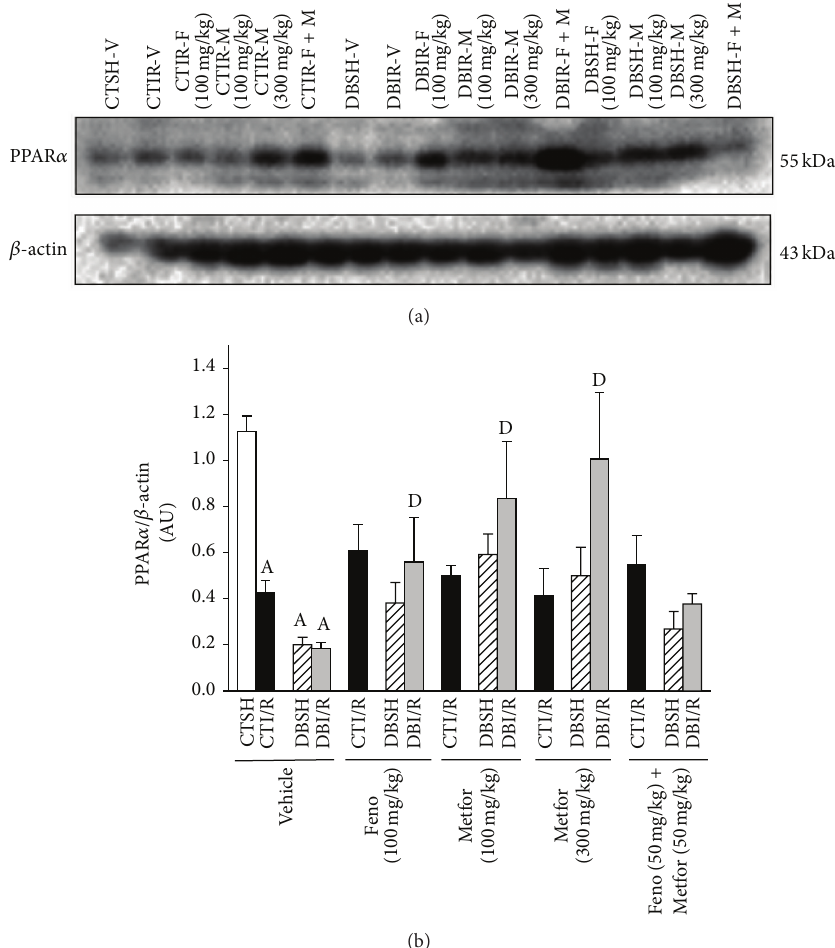
Figure 5: Subchronic treatment with fenofibrate (F), metformin (M), and their combination prevented the decreased expression of PPAR 𝛼 in diabetic-ischemia/reperfusion (DBI/R) conditions. (a) Representative immunoblot and (b) PPAR 𝛼 expression in ischemic left ventricle area ( 𝑛 = 4 rats/group). A 𝑃 < 0.05 versus control-sham- (CTSH-) Vehicle and D 𝑃 < 0.05 versus DBI/R-Vehicle two-way ANOVA followed by Duncan’s post hoc test. Data are presented as means ±